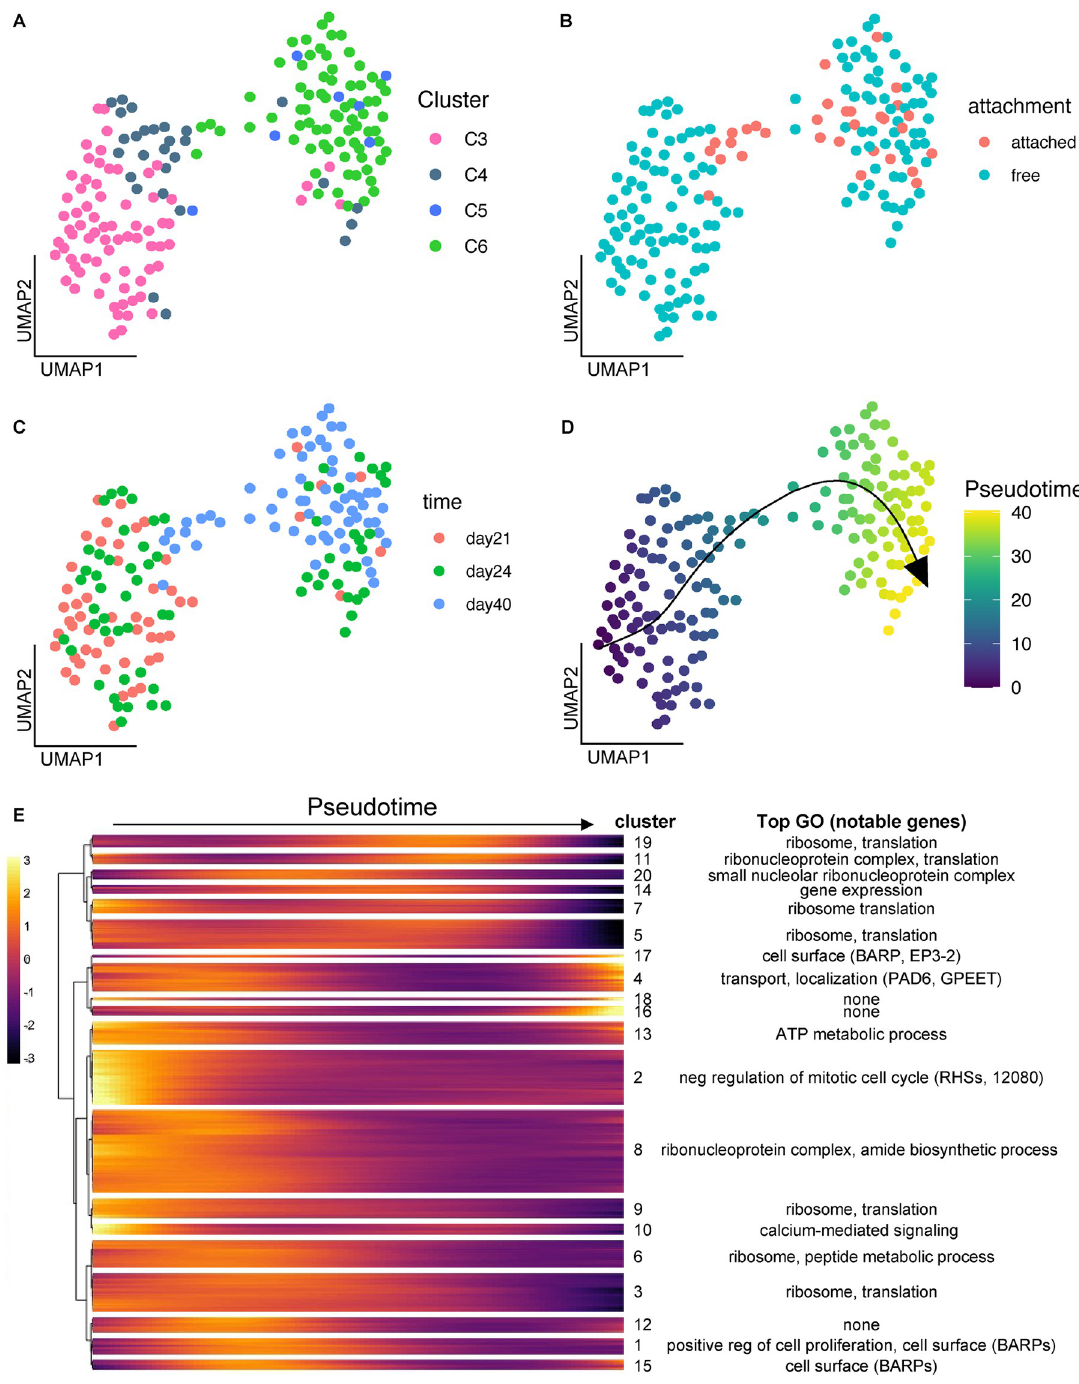
Fig 3. Pseudotime trajectory analysis of developing salivary gland parasites. Strain 1738 parasites collected from the salivary gland at day 21, 24 and 40 pi were used to map fine-scale changes in gene expression over development. (A-D) A UMAP of the 161 strain 1738 salivary glands parasites coloured by global cluster assignment from Fig 1 (A), day PI (B), attachment treatment (C) and pseudotime assignment (D). (E) A heatmap of 20 clusters of genes differentially expressed over the pseudotime trajectory from (D).